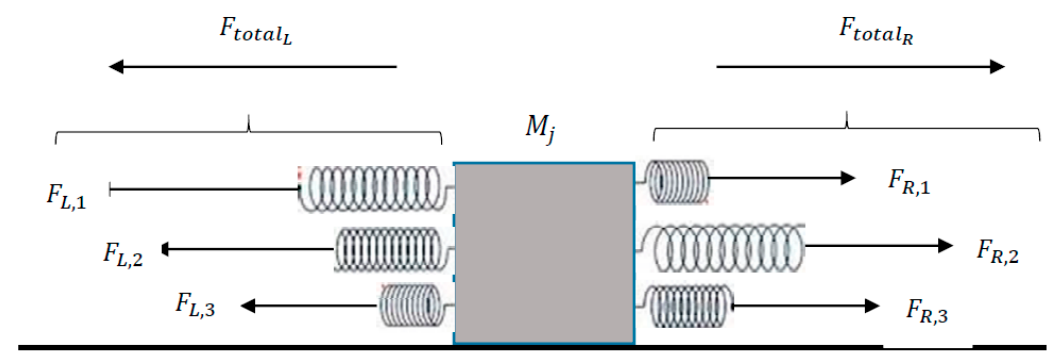
Figure 1. An isolated system is composed of object and spring forces.